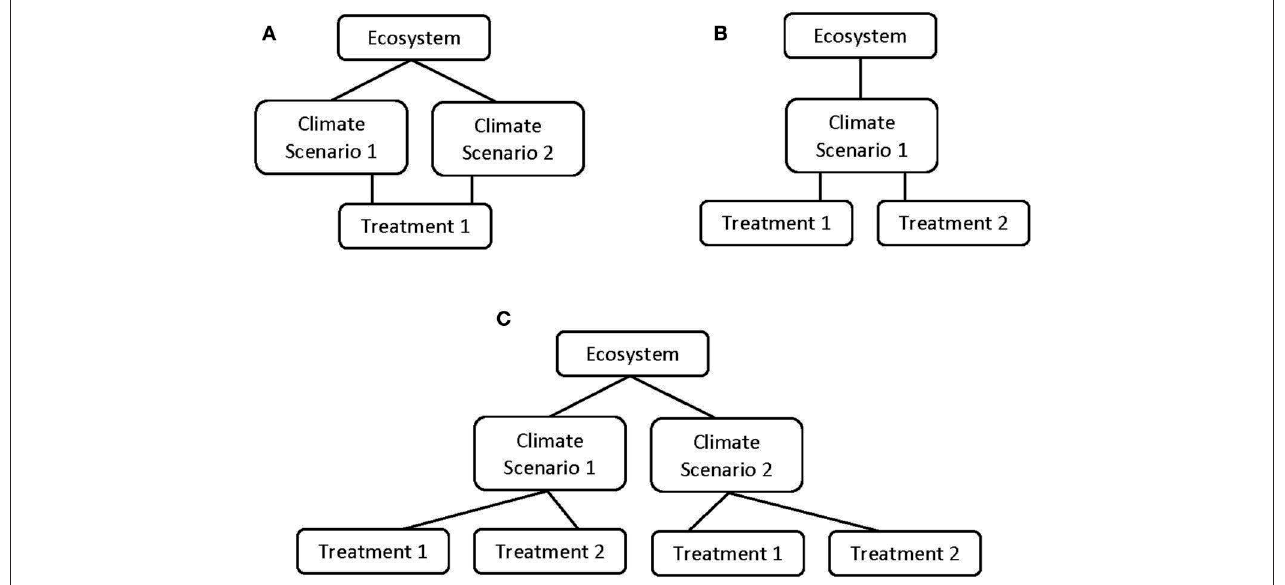
FIGURE 2 | The future comparative modeling approach evaluates ecosystem responses under a range of climate futures and management strategies. Scenario comparisons can include impacts of several climates and a single management strategy (A) , different management strategies within a single modeled climate (B) , or factorial comparisons of several climate futures and management strategies (C) . Adapted from Friggens et al. (2019).